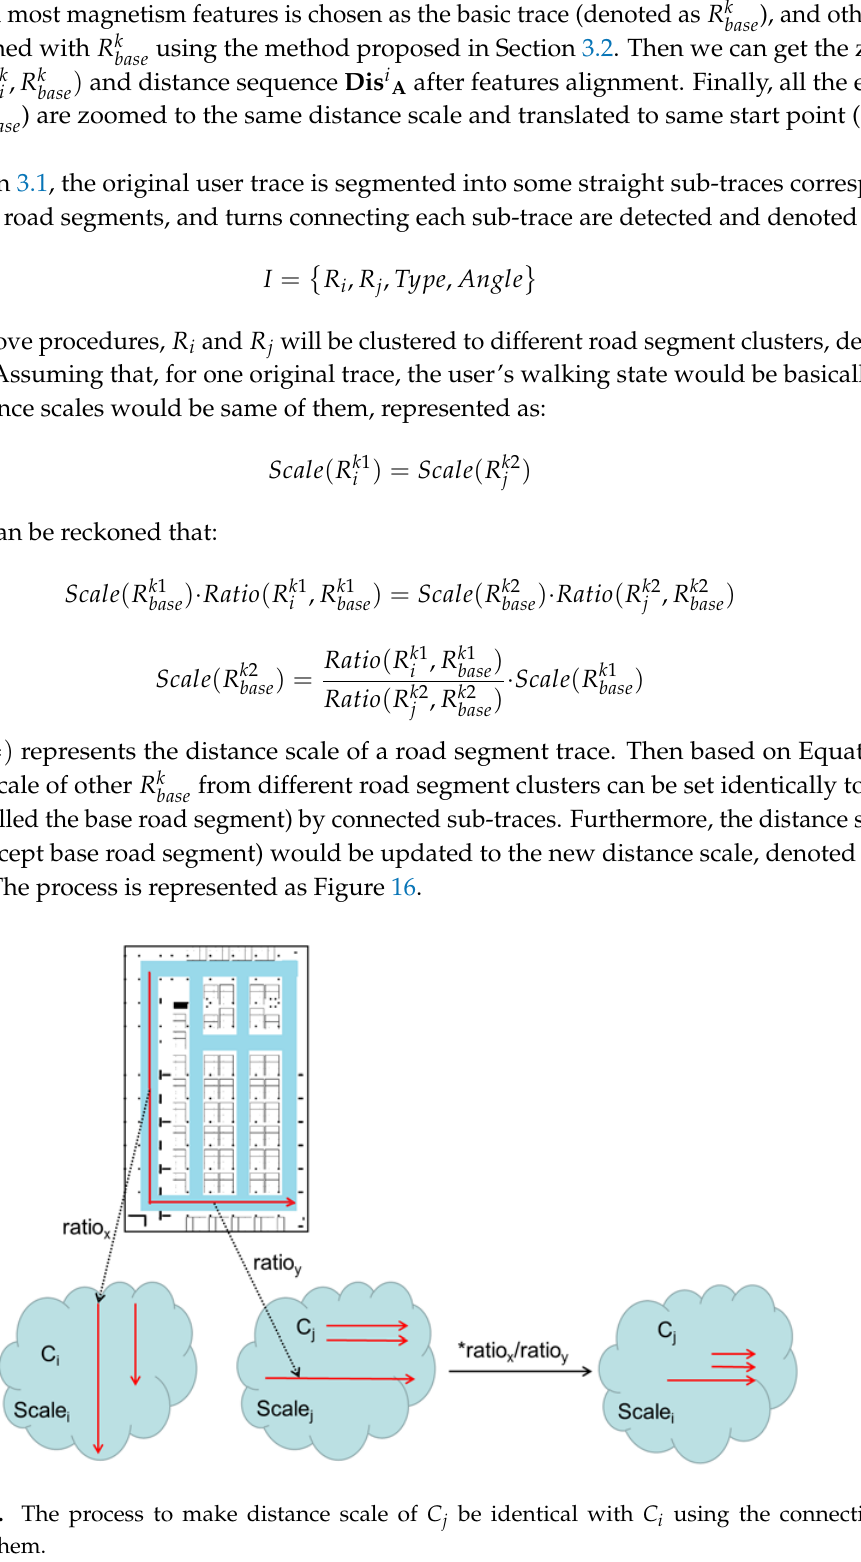
Figure 16. The process to make distance scale of C j be identical with C i using the connections between them.